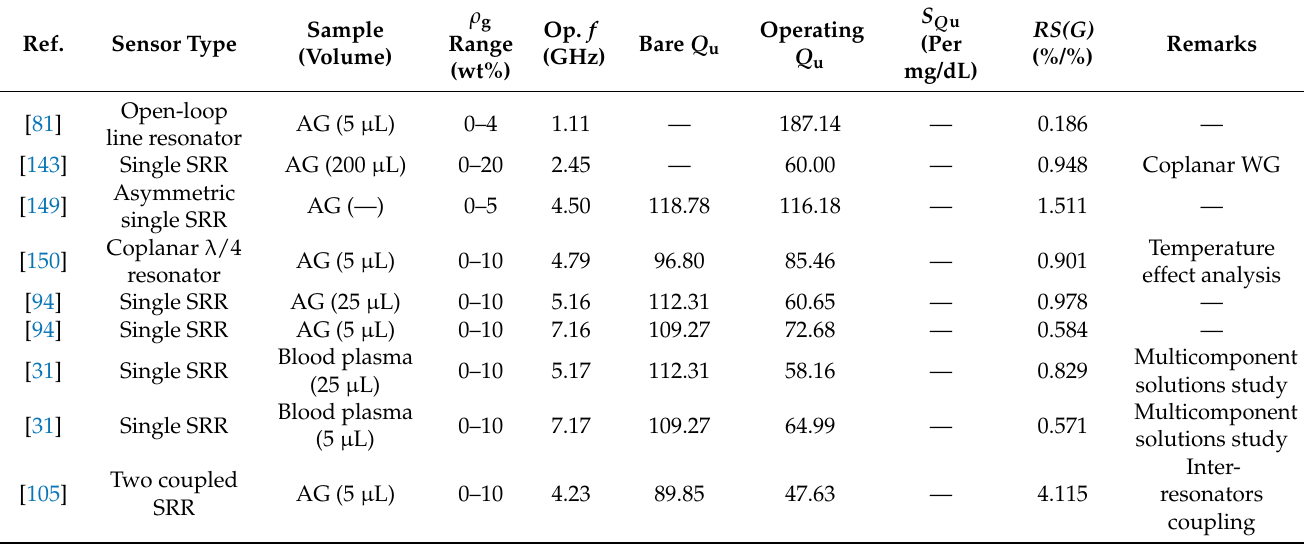
Table 3. Quality factor-based sensors. AG = aqueous glucose solutions; WG = waveguide.